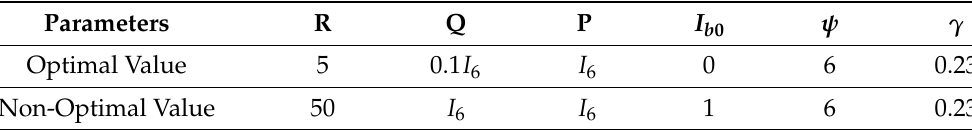
Table 3. Initial parameters used for the filters.